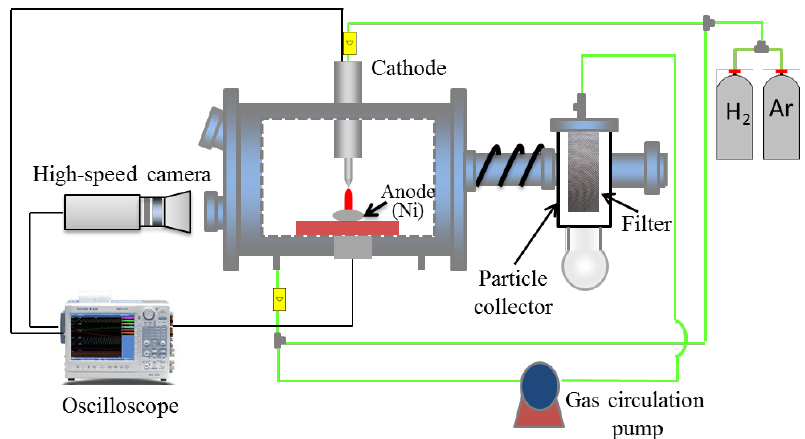
Figure 1. Schematic of the experimental setup for nickel nanoparticle production by direct current (DC) arc discharge method.